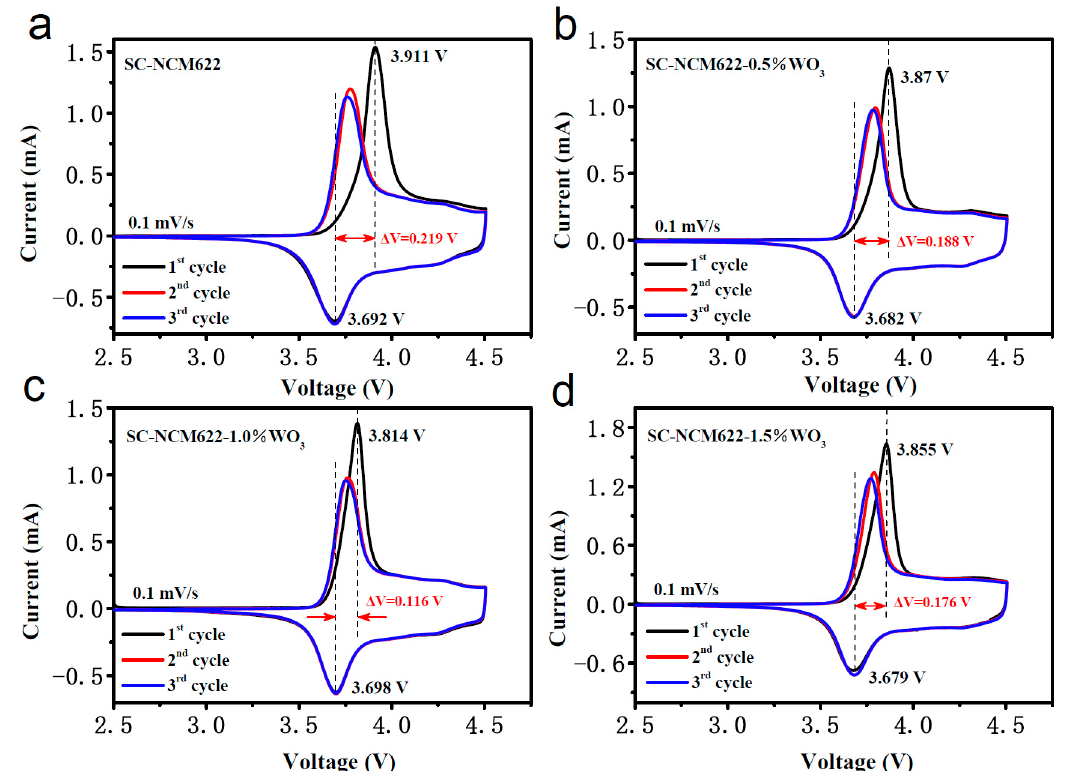
Figure 6. The cyclic voltammetry curves of ( a ) SC-NCM622, ( b ) SC-NCM622-0.5%WO 3 , ( c ) SC-NCM622-1.0%WO 3 and ( d ) SC-NCM622-1.5%WO 3 in fresh coin cells.